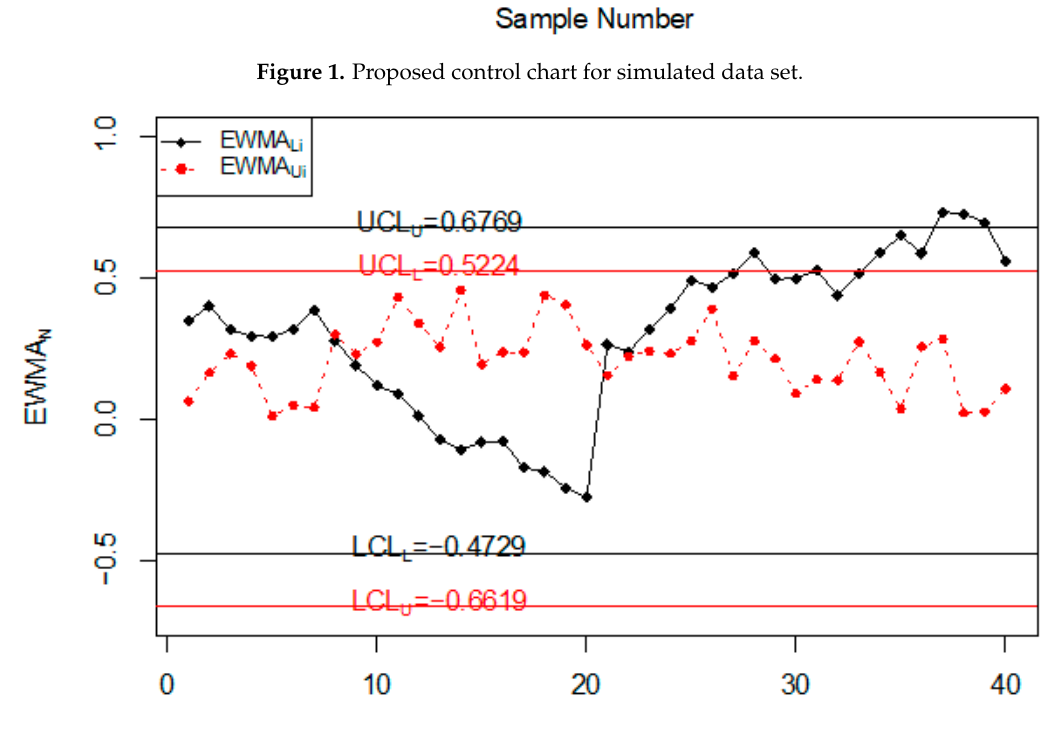
Figure 2. The control chart by [33] for simulated data set.